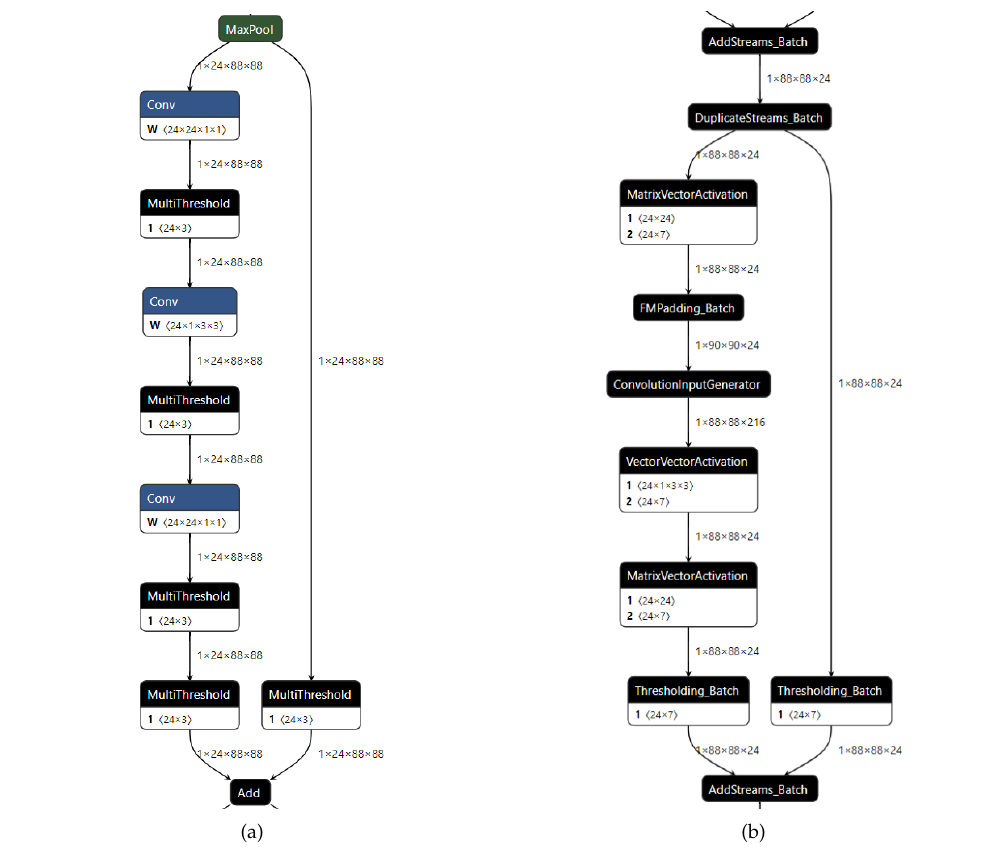
Figure 14. Two-step conversion operation in the FINN framework. ( a ) The network transformed by the streamline step. ( b ) The network transformed by the conversion to HLS